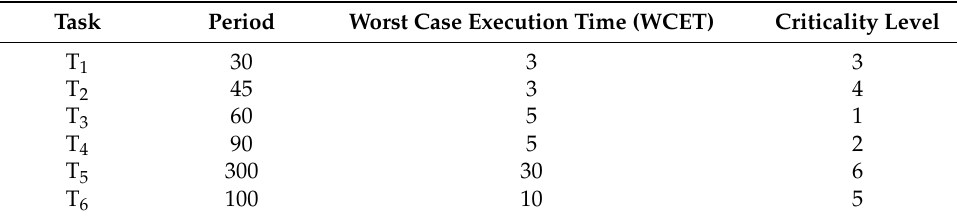
Figure 5. Adaptive feedback-based scheduling. Table 1. Sample real-time task